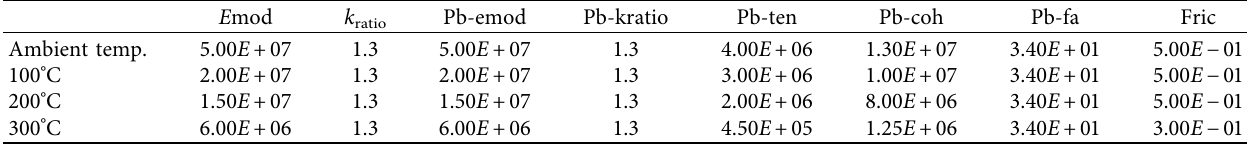
Table 6: Contact parameters of particles in the mortar area.